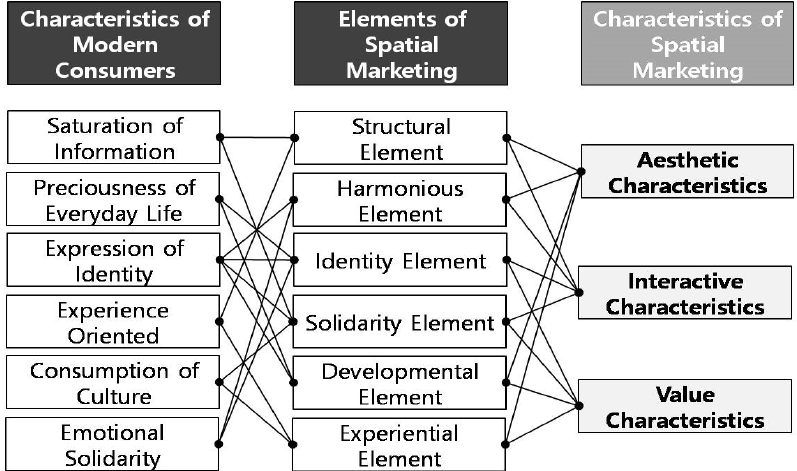
Figure 15. Characteristics of the spatial marketing of coffee shops.